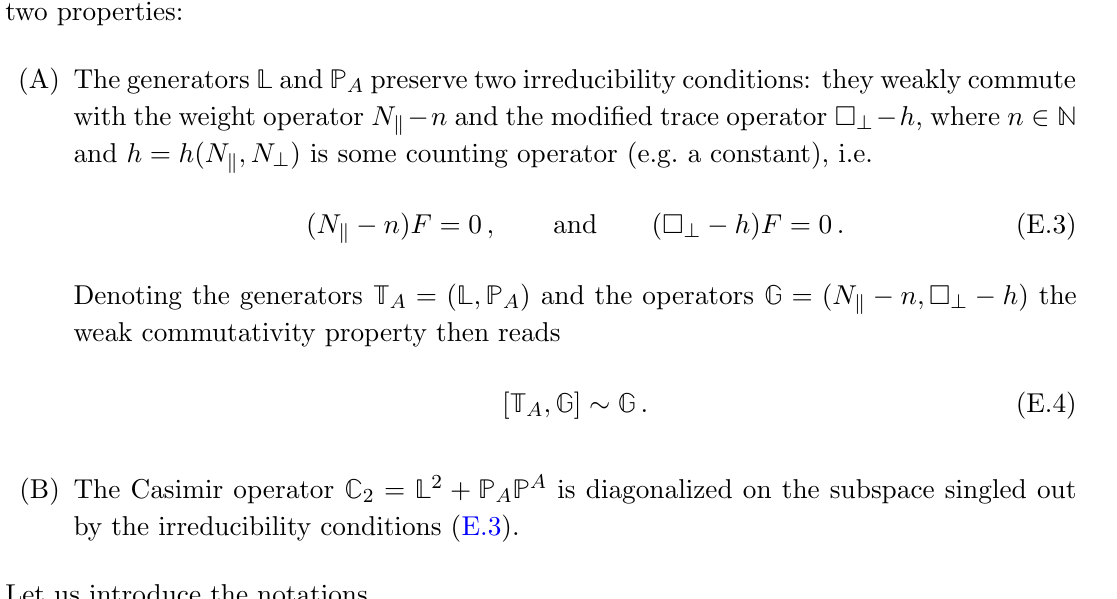
are shown in red contours. The W n